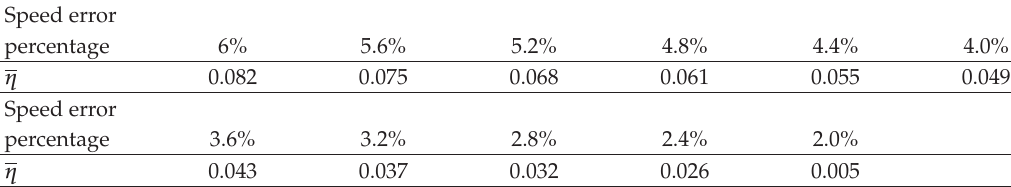
Table 2: The relationship between the speed tracking error and η